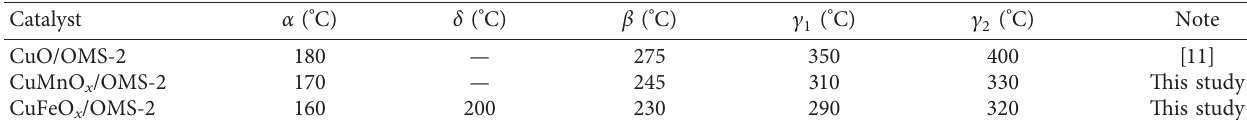
Figure 6: TPR patterns of catalysts with different temperature ranges: (1) CuO/OMS-2, (2) CuMnO x /OMS-2, and (3) CuFeO x /OMS-2. Table 2: The reduction temperature of peaks in H 2 -TPR profile of